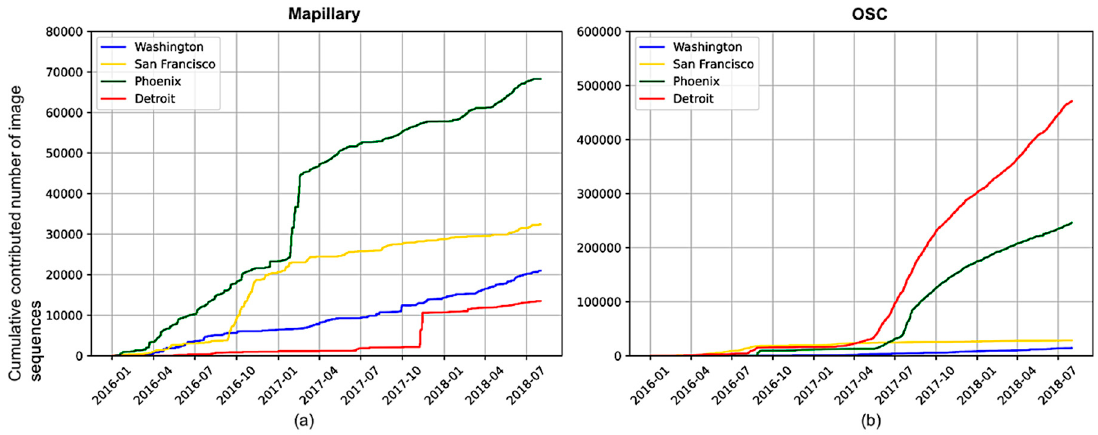
Figure 12. Cumulative lengths of image sequences contributed over time in ( a ) Mapillary and ( b ) OSC.